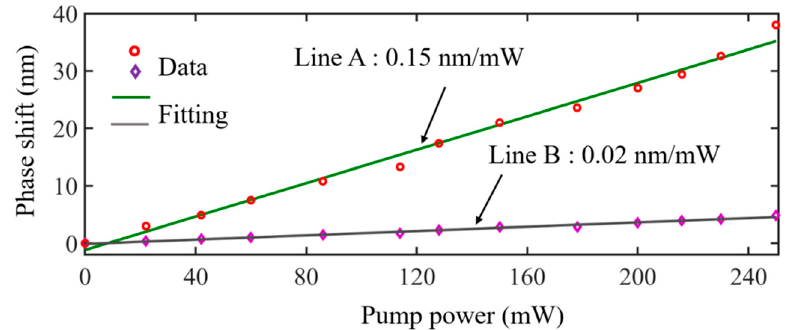
Figure 7. Modulation efficiency of (Line A) MXene-MKR and (Line B) cascade system.